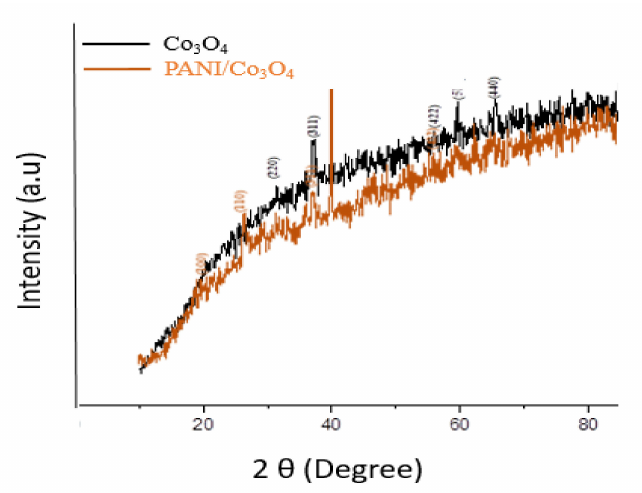
Figure 8. XRD of Co 3 O 4 and PANI/Co 3 O 4